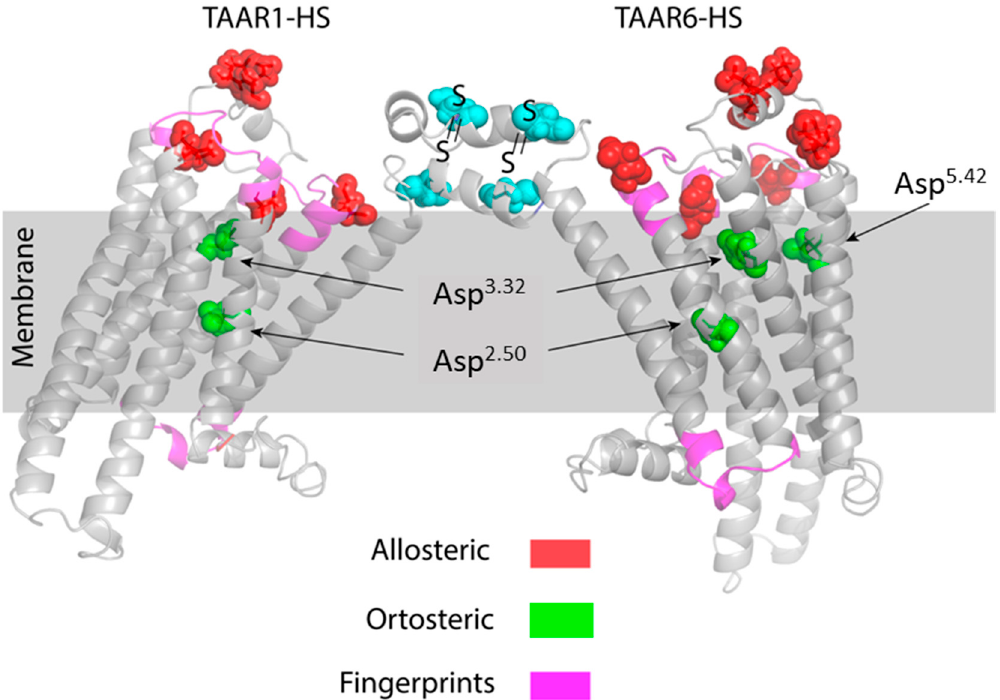
Figure 2. Spatial structures of the human TAAR1 and TAAR6 receptors were predicted using the GPCR-I-TASSER program [32]. The group of conservative motives (fingerprints) predicted using the PRINTS Database program is highlighted in magenta. Potential allosteric binding sites for positively charged ligands TAAR1 and TAAR6 on the membrane surface are highlighted in red; orthosteric binding sites for aliphatic ligands are shown in green. Possible S–S disulfide bridges in the presumed TAAR1 and TAAR6 heterodimer are highlighted in cyan. All crystal structures were visualized with PyMol.